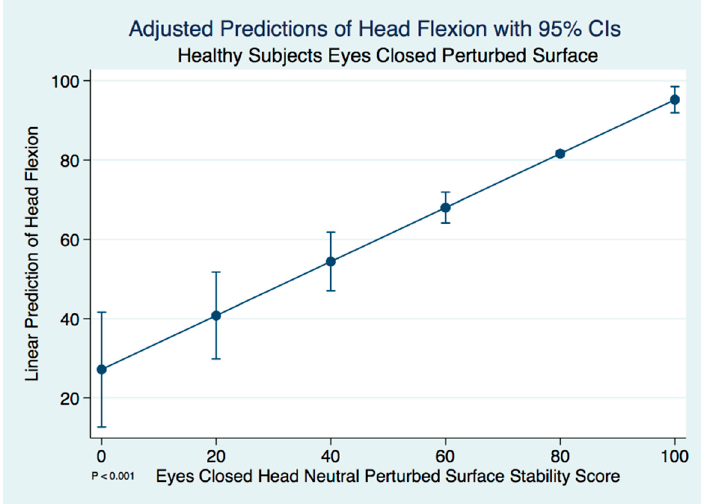
Figure 6. Adjusted predictions of head flexion stability scores in healthy normal controls.